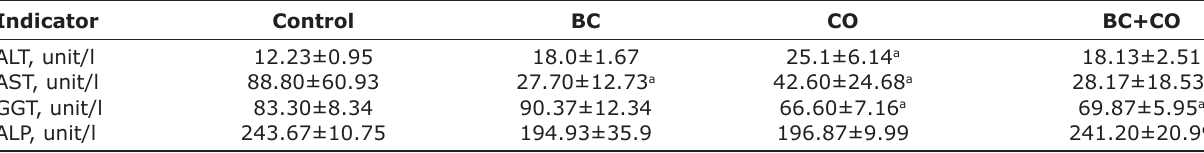
Table-5: The activity of serum enzymes with Bacillus cereus and coumarin in diets (day 42). Indicator Control